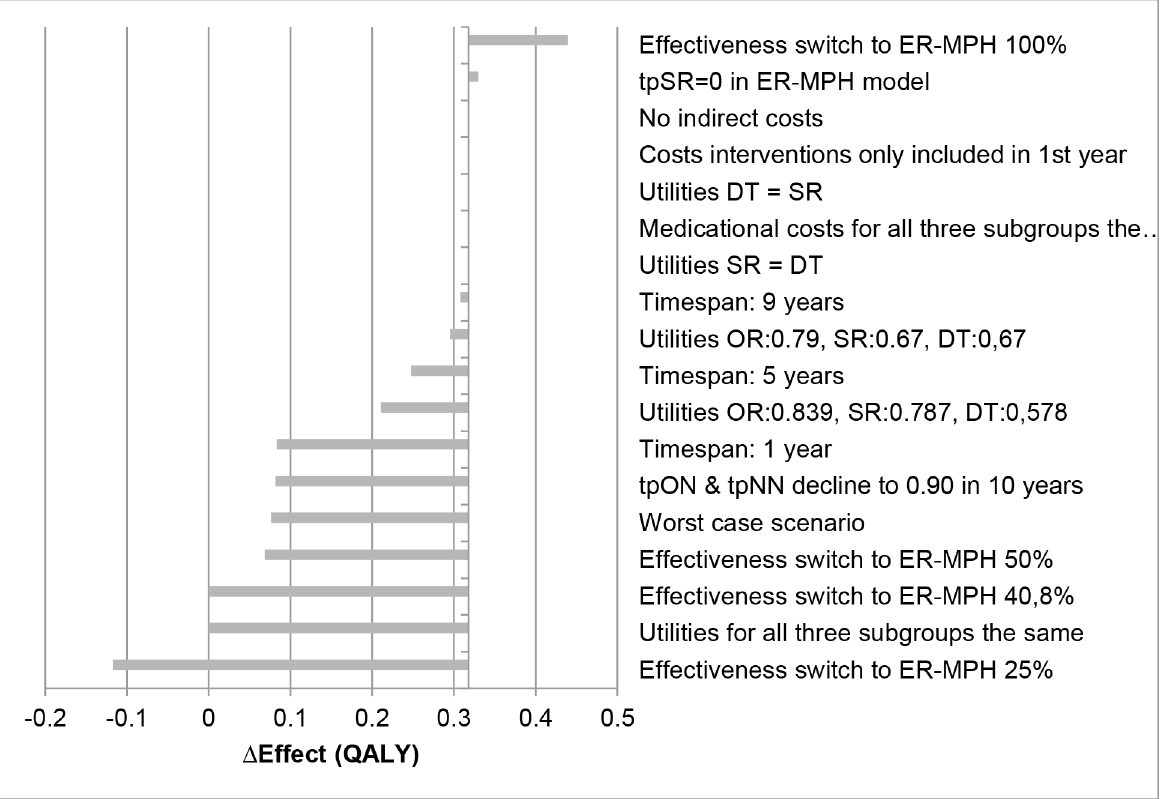
Fig 7. Effect of the scenario analyses on the outcome of effect (QALY) (IR-MPH vs ER-MPH). Illustrative result for ER-MPH, example of MPH-OROS. tp = transition probability, SR = suboptimal response, OR = optimal response, DT = discontinuing treatment, NR = natural remission, IR-MPH = immediate release methylphenidate, ER-MPH = extended release